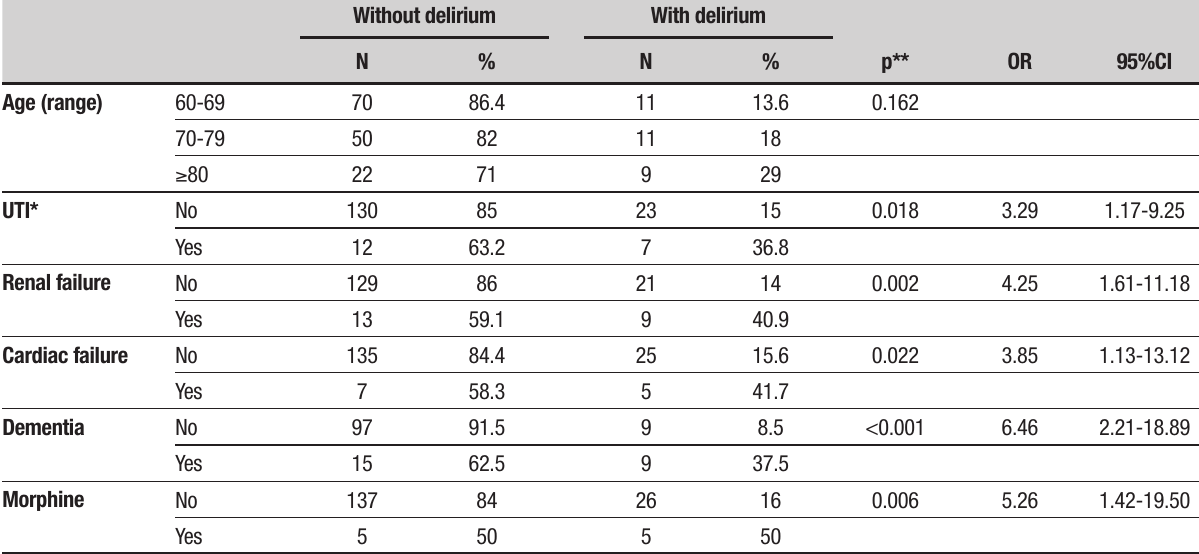
Table 2. Comparison of participants with and without delirium for sociodemographic variables, clinical conditions and medications. Without